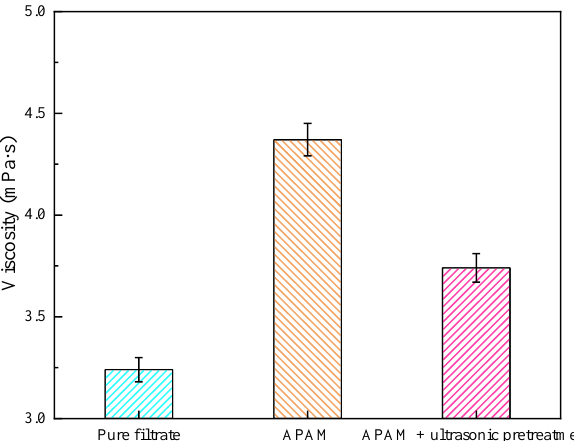
Figure 10. Viscosity change of filtrate before and after ultrasonic pretreatment.